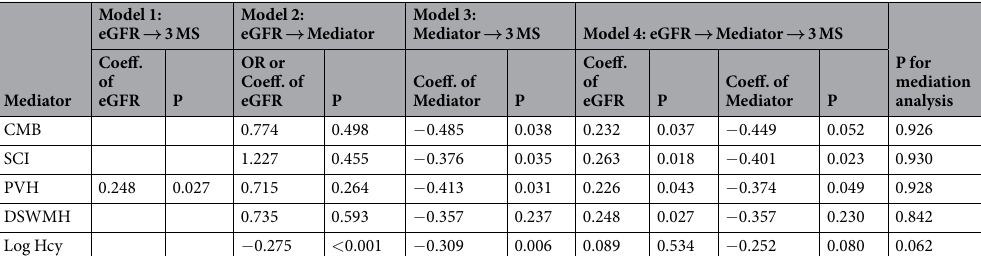
Table 2. Mediation analysis. We tested a hypothesis that a higher homocysteine concentration and/or the presence of SVD (CMB, SCI, PVH or DSWMH) are mediator(s) of the association between eGFR and 3 MS in patients with diabetes mellitus. The multivariate models were adjusted for 12 potential confounders such as age, sex, apolipoprotein E4 isoform, prior cardiovascular disease, duration of diabetes mellitus, HbA1c, hypertension, dyslipidemia, log-transformed urine albumin to creatinine ratio, education, log-transformed serum vitamin B12, and log-transformed serum folate levels. Model 1 indicates the association of eGFR with 3 MS without considering the effect of the mediator. Mode 2 indicates the association of eGFR with the mediator by showing the adjusted odds ratios (per 1 standard deviation of eGFR) for CMB, SCI, PVH and DSWMH and the standardized regression coefficient for log-homocysteine. Model 3 examined the association of the mediator with 3 MS. Model 4 includes both eGFR and the mediator simultaneously to give the association of eGFR with 3 MS and the association of the mediator with 3 MS. P for mediation analysis indicates whether the coefficients of eGFR before (Model 1) and after inclusion of the mediator (Model 4) is significantly different. In all models, variable inflation factor was 3.462 or lower. Abbreviations are: 3 MS, modified mini-mental state examination; eGFR, estimated glomerular filtration rate; CMB, cerebral microbleed; SCI, silent cerebral infarction; PVH, periventricular hyperintensity; DSWMH, deep and subcortical white matter hyperintensity; Hcy, homocysteine; OR, odds ratio; Coeff., standardized regression coefficient (ß); P, level of